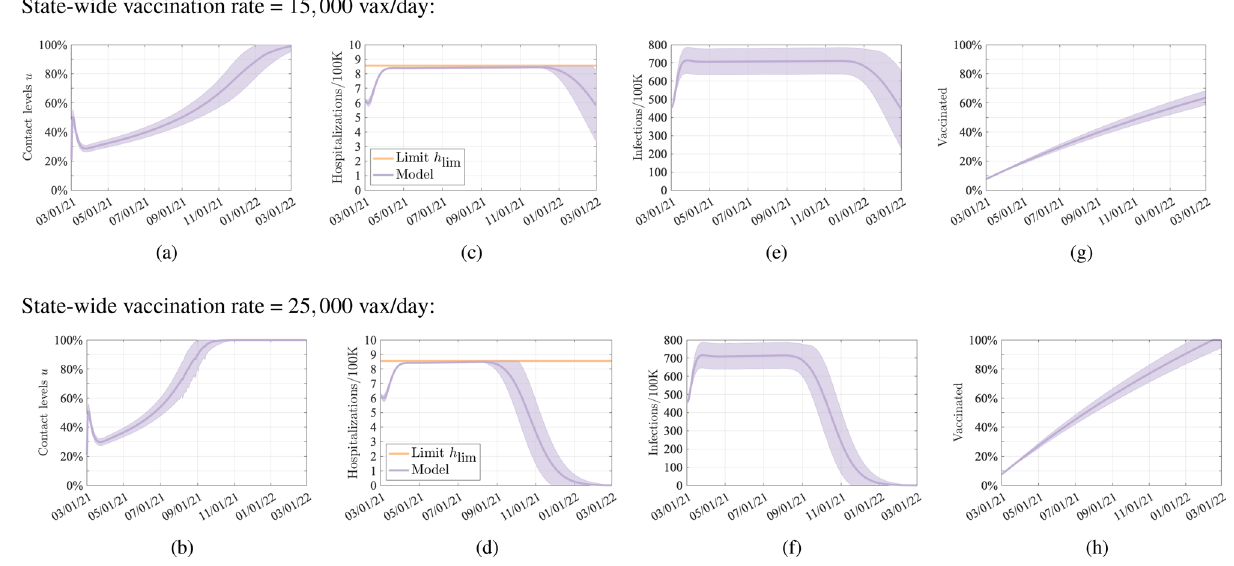
Figure 1. Model behavior when the feedback law is designed to simultaneously maximize contact levels and maintain hospitalizations below the threshold h lim . ( a,b ) Level of transmission-relevant contacts with respect to pre-pandemic behavior, as selected by the feedback controller. All simulations are conducted by using a single region model that is fitted using data from the state of Colorado, USA (see “Methods” section). Results are averaged over 10,000 simulations with parameters sampled using a Latin Hypercube technique within 15% of their nominal values. Continuous line shows mean of the trajectory and shaded area show 99.73% confidence intervals. This figure shows an ideal situation where vaccination uptake can reach a level of 100%.